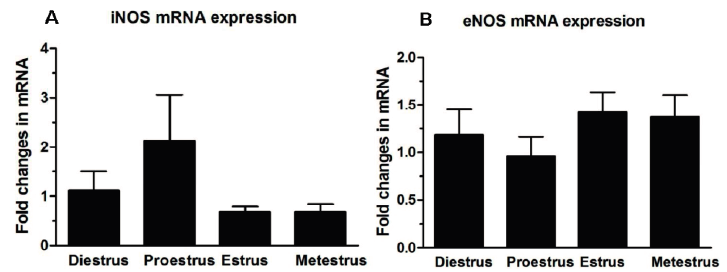
Figure 2. Quantitative RT-PCR analysis of iNOS ( A ) and eNOS ( B ) mRNA levels in adult mouse Fallopian tubes at different stages of the estrous cycle ( n = 10/group). mRNA levels of each gene were relative to 18S rRNA levels in the same samples. Significance was tested by one-way ANOVA with Dunnett’s test, and no significant differences were found